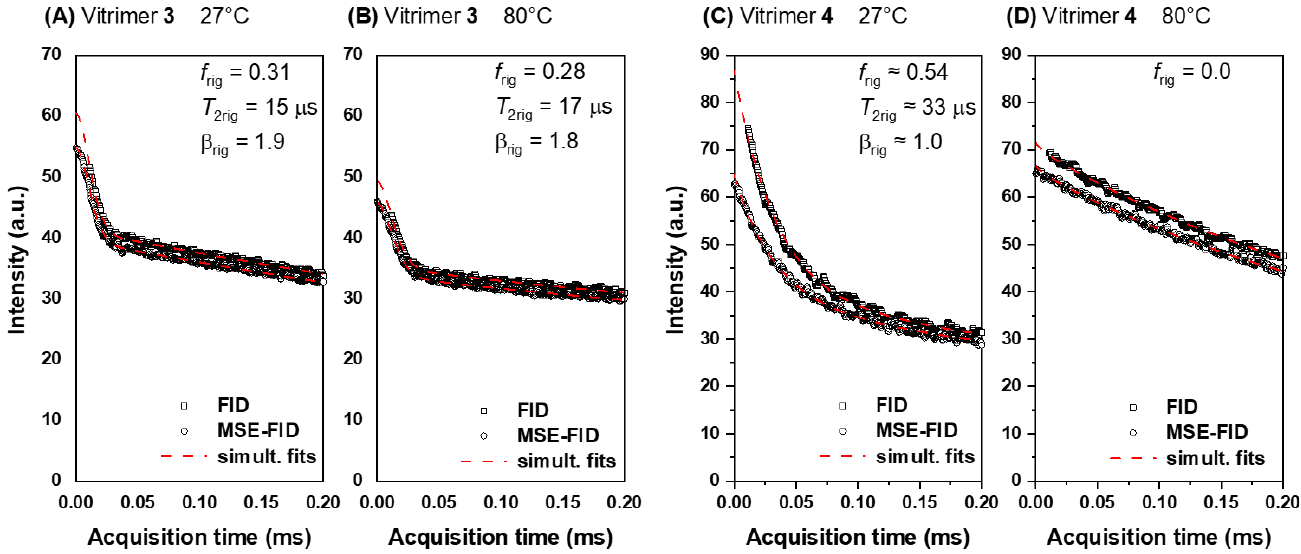
Figure 5. The free-induction decay (FID) and MSE-refocused FID analyses of Vitrimer 3 ( A , B ) and Vitrimer 4 ( C , D ) at different temperatures.